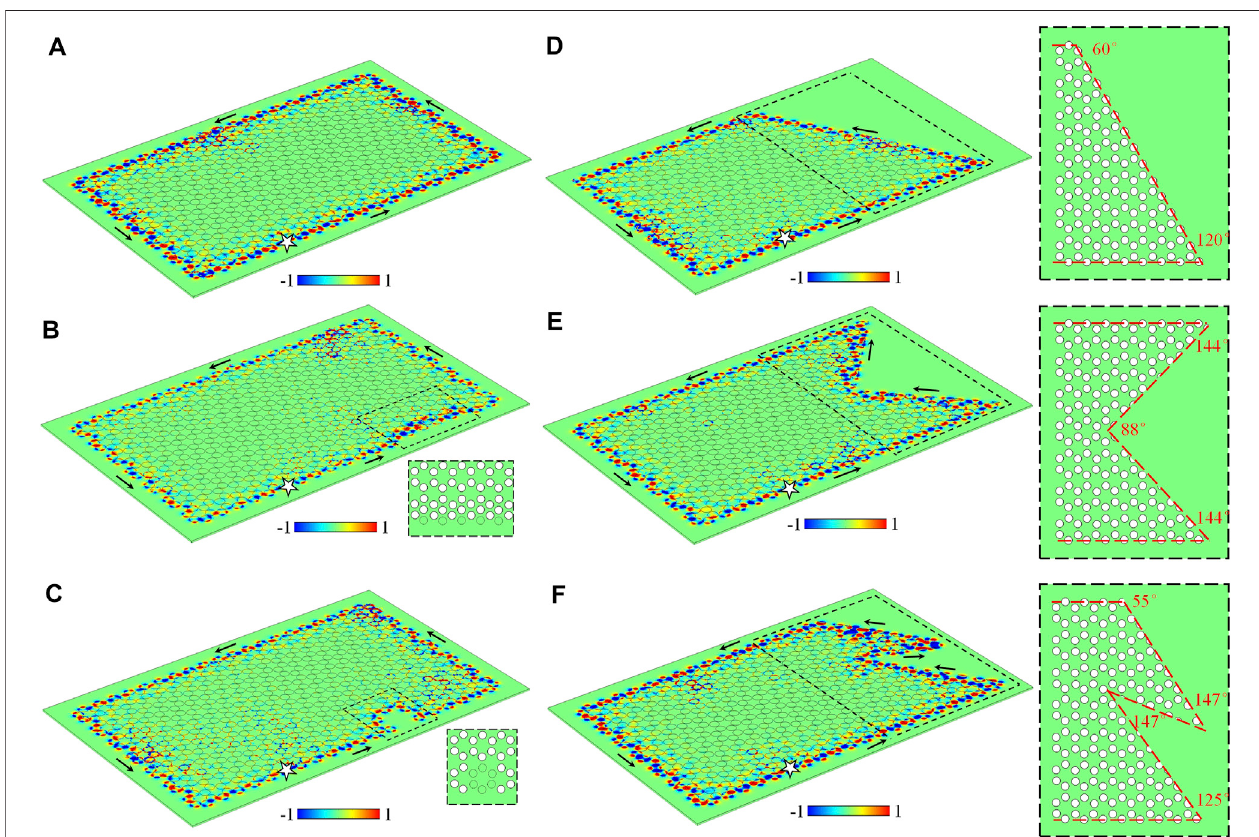
FIGURE3| Topologicalone-wayedgestatesinair-holeGPCs ofvarious geometries. (A) Aperfect rectangularhoneycombGPC. (B) Animperfect zigzaginterface is created by moving a line of fi ve air holes at the lower zigzag edge along the y direction with a distance of 0.55 a . (C) A defected zigzag interface is constructed by replacing a honeycomb lattice of six air holes with six YIG cylinders of same size. (D – F) Three irregular air-hole GPCs of various geometries. The angle of sharp corner is marked near the corner and the transport interfaces are marked as the red dotted lines.